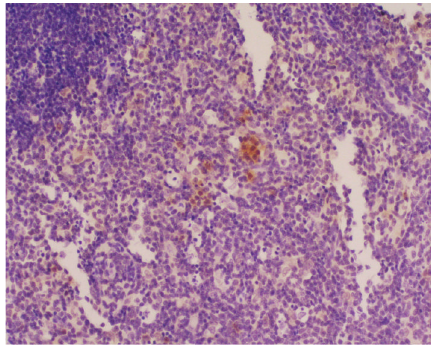
Figure 9: Treated group: 3 hours; Caspase-3 × 200.